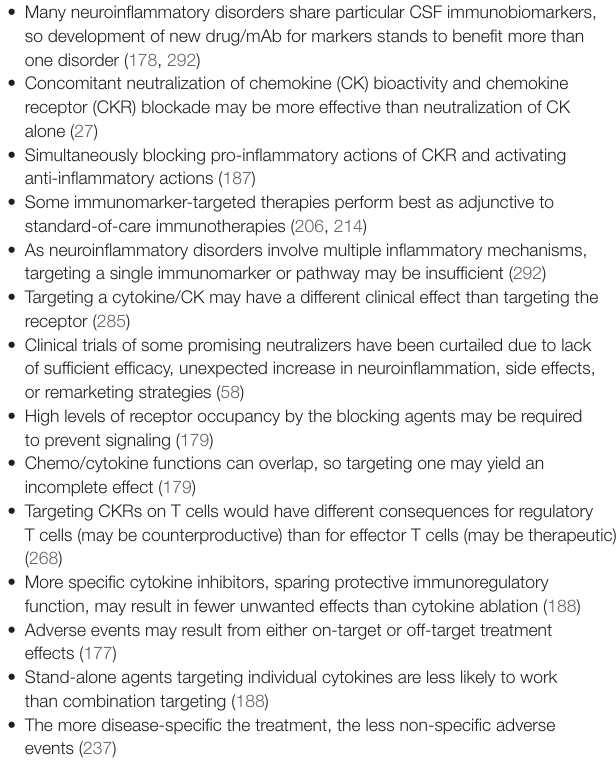
TABle 10 | Strategic insights from clinical trials and preclinical studies of chemo/ cytokine-targeted therapy. • Many neuroinflammatory disorders share particular CSF immunobiomarkers, so development of new drug/mAb for markers stands to benefit more